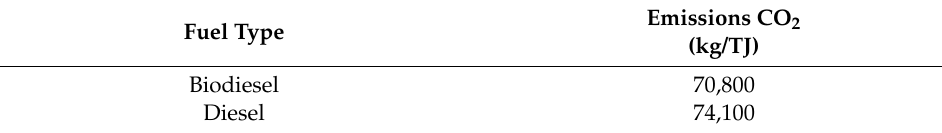
Table 12. Aspects of emissions of CO 2 from biodiesel and diesel [173].